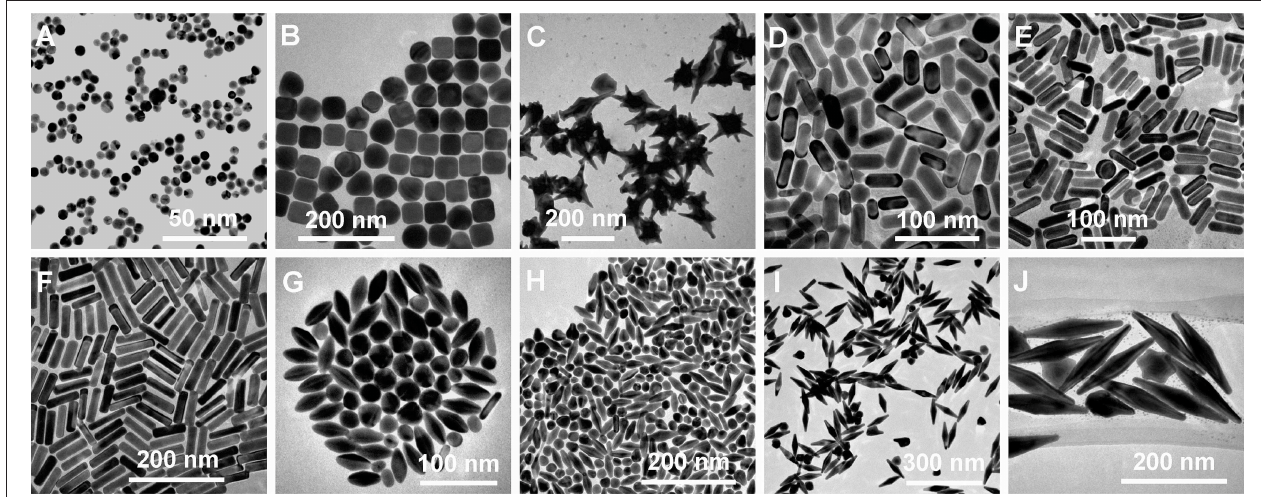
FIGURE 4 | Diversity of gold nanostructures. (A) Nanospheres. (B) Nanocubes. (C) Nanobranches. (D) Nanorods (aspect ratio = 2.4 ± 0.3). (E) Nanorods (aspect ratio = 3.4 ± 0.5). (F) Nanorods (aspect ratio = 4.6 ± 0.8). (G) Nanobipyramids (aspect ratio = 1.5 ± 0.3). (H) Nanobipyramids (aspect ratio = 2.7 ± 0.2).